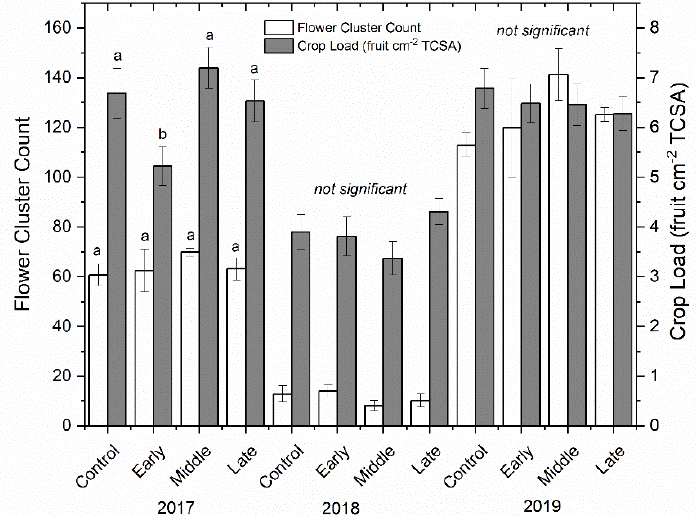
Figure 3. Mean bloom clusters per tree (cm) ( ± SE; n = 3) (left-axis; white bars) and crop load (right-axis; grey bars) for ‘Honeycrisp’ apple in 2017 (left), 2018 (middle), and 2019 (right). Four treatments were established including a well-watered control, early season deficit (16–45 days after full bloom [DAFB]), mid-season deficit (46–75 DAFB), and late season deficit (76–105 DAFB). Letters denote significance among treatments within each year determined using a Tukey’s HSD test ( α = 0.05).